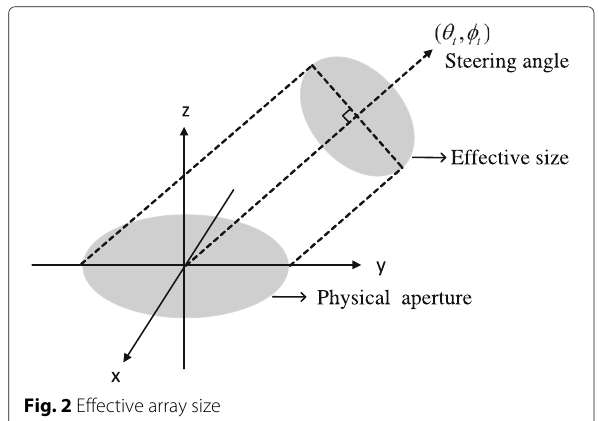
Fig. 2 Effective array